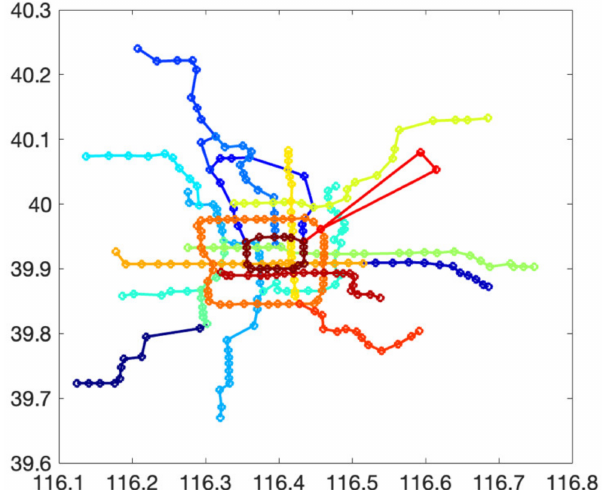
Figure 6. Schematic of the results of the subway line resilience